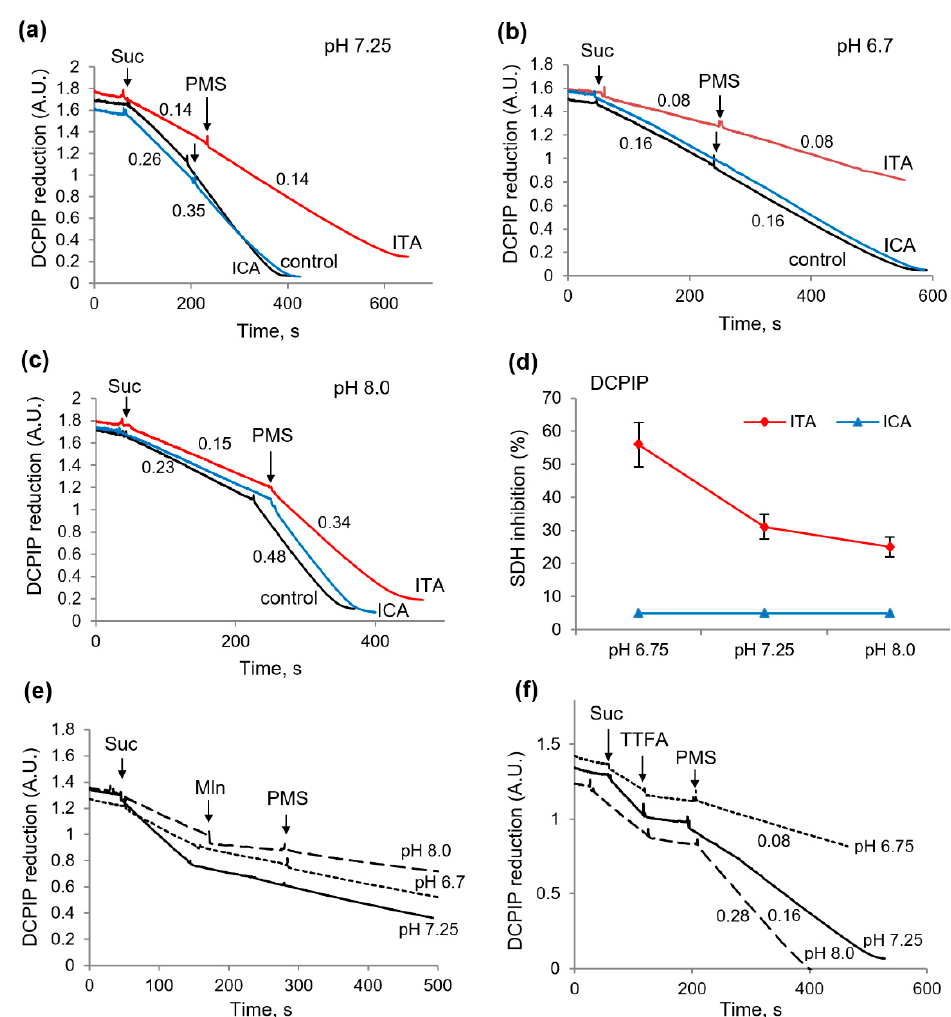
Figure 5. Influence of itaconic and indolcaboxylic acids on the activity of SDH, as measured by DCPIP reduction. DCPIP reduction in the course of succinate (2 mM) oxidation in the presence of ITA (2 mM) and ICA (250 μ M) at medium pH equal to 7.25 ( a ), 6.7 ( b ), and 8.0 ( c ), and SDH inhibition (%) at different pH values ( d ). The influence of the inhibitors of SDH malonate (2 mM) ( e ) and TTFA (200 μ M) ( f ) on DCPIP reduction and activation by PMS (250 μ M) at different pH values of medium; the rates of DCPIP reduction, Δ D/min, are indicated in parentheses.